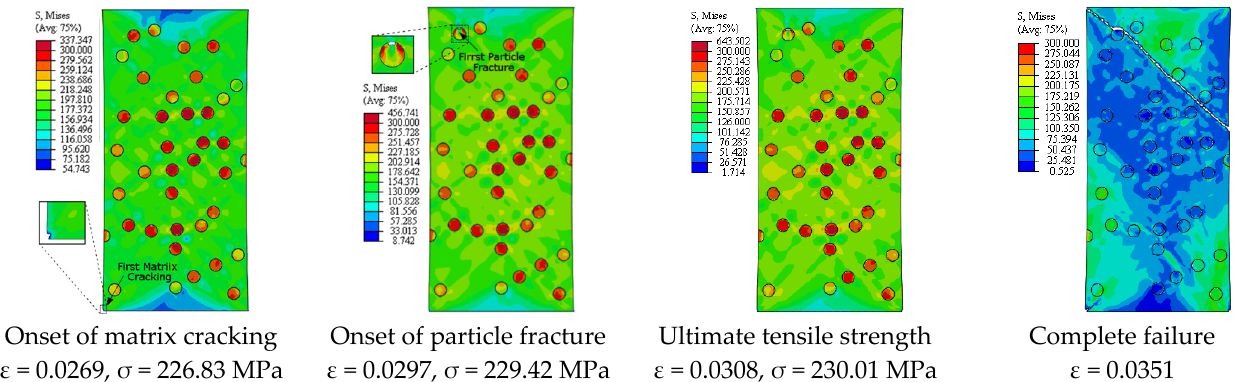
Figure 8. Failure propagation and von Mises stress distribution of A359/SiC composite at 10% VF (PS = 10 µm).